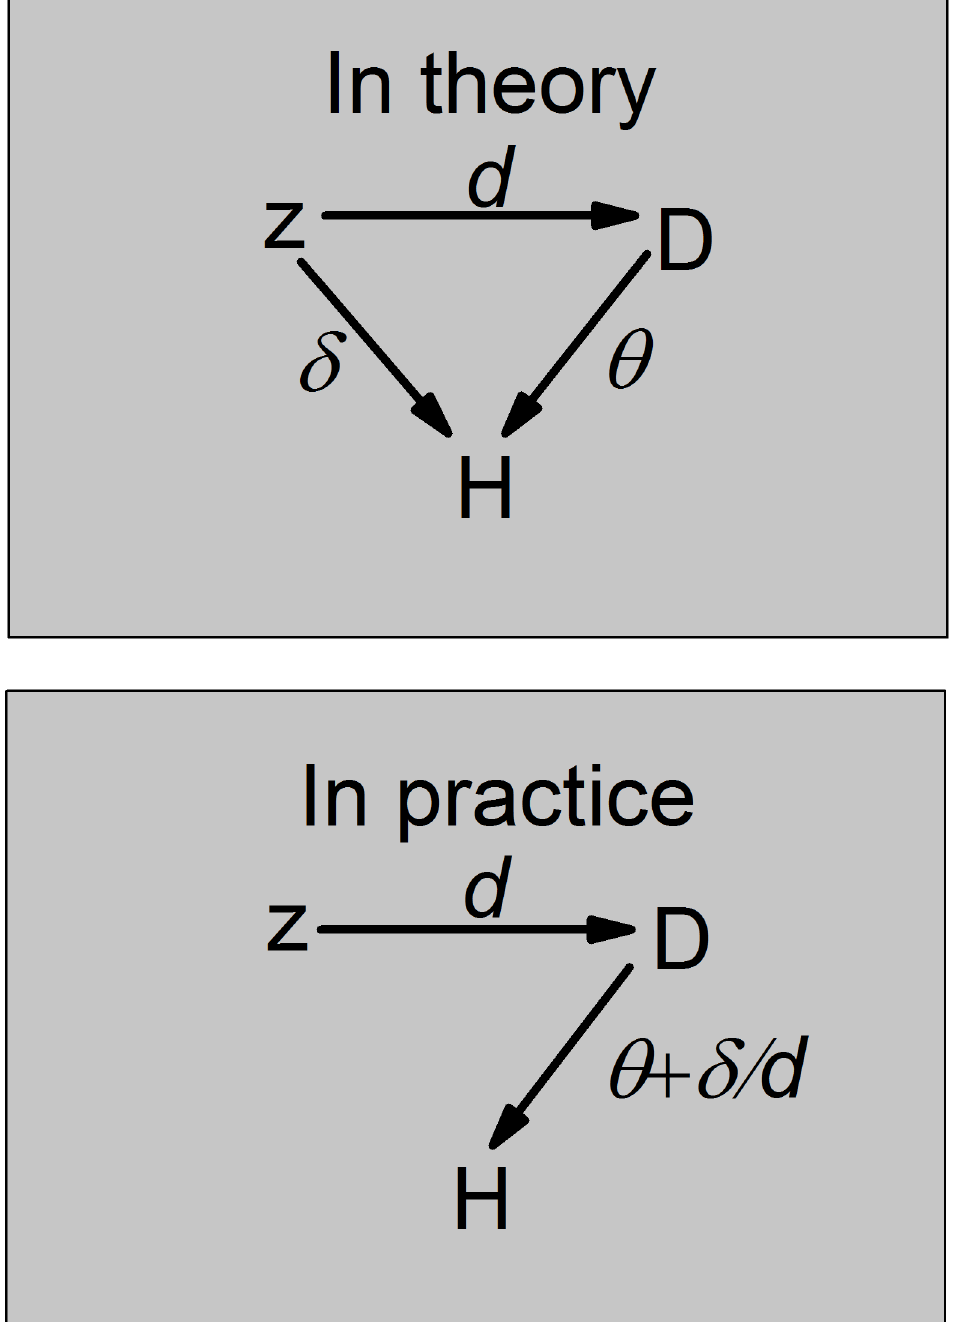
Fig 1. The effect of omitting z from the health outcome equation. In theory, the total effect of z on health outcome, H, is δ + θ d . In practice, using z as an instrumental variable causes bias in the estimated effect of the 25(OH)D score, D , on the health outcome, because the direct effect of z on the health outcome is incorrectly captured as being mediated by D